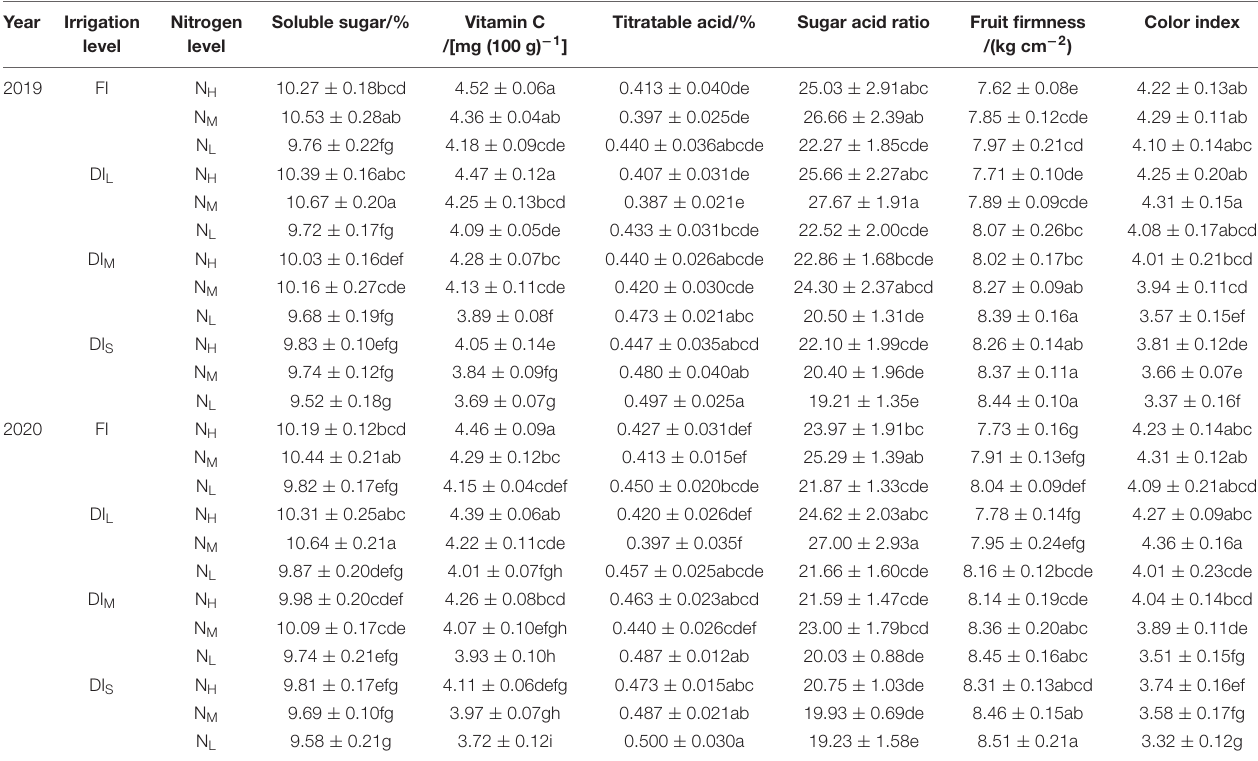
TABLE 2 | Effects of water and nitrogen coupling on quality of mountain